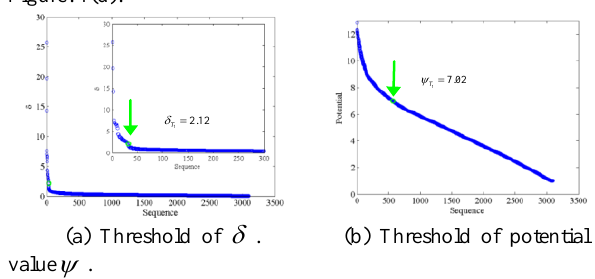
Figure 2. Cluster center selection.